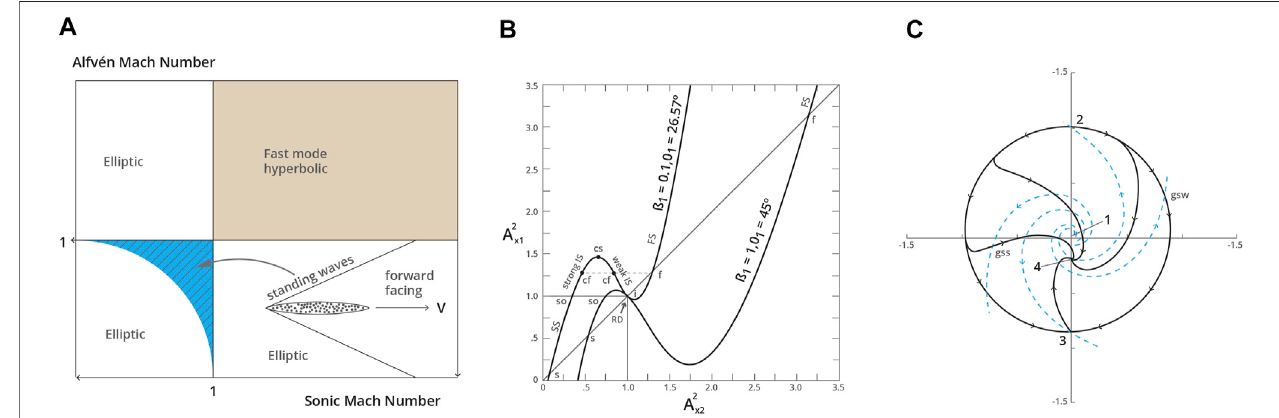
FIGURE 1 | Standing waves and shocks in MHD: (A) Standing upstream-facing slow mode waves in blue shaded region; (B) Slow, intermediate, and fast shock wave jump properties from upstream (1) to downstream (2) conditions; angle θ 1 , is between shock normal and upstream magnetic fi eld (C) Example of predicted magnetic hodogram for a shock structure.